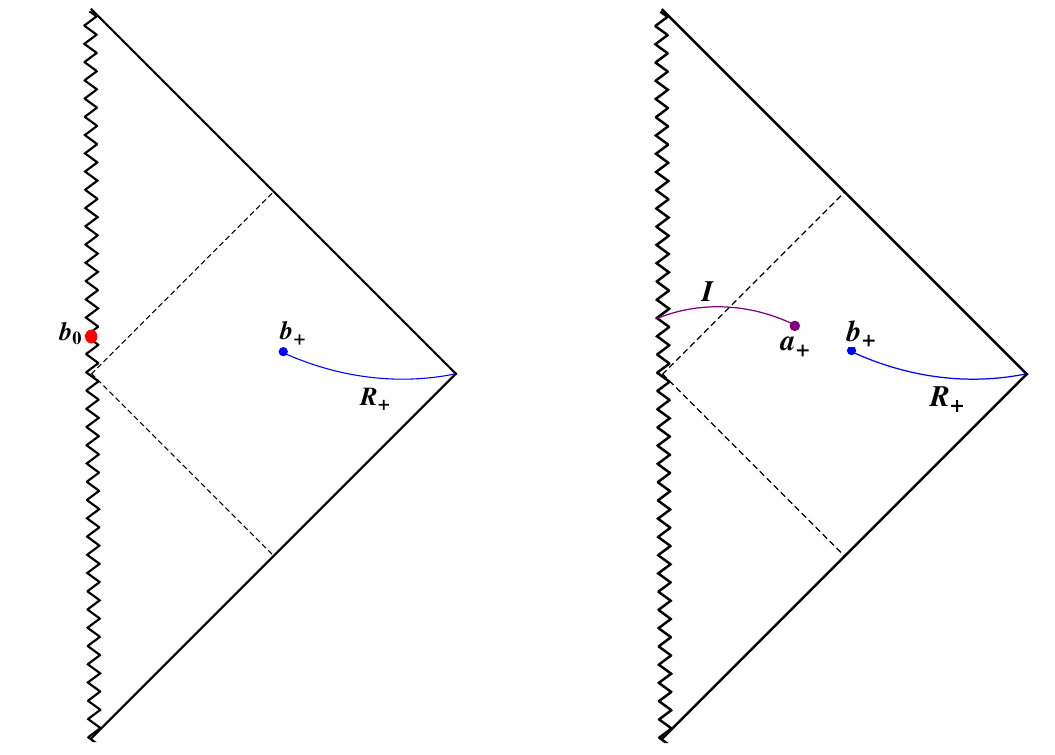
Fig. 7 The Penrose diagram of the eternal extremal charged black hole in massive gravity without island (left panel) and with one island (right panel). The radiation region is represented by R + with the boundary b + . I denotes the island extending from the singularity to its boundary a +